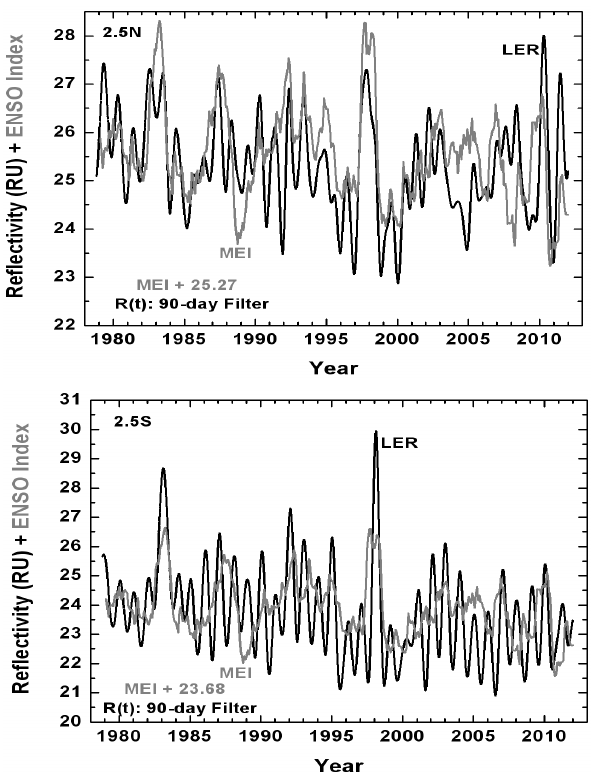
Fig. 6. A comparison of the LER (black) with the scaled MEI + R AVG (grey) for the latitude bands 0 to 5 ◦ N (top) and 0 to 5 ◦ S (bottom). The LER is a 90-day low-pass filter of the daily LER time